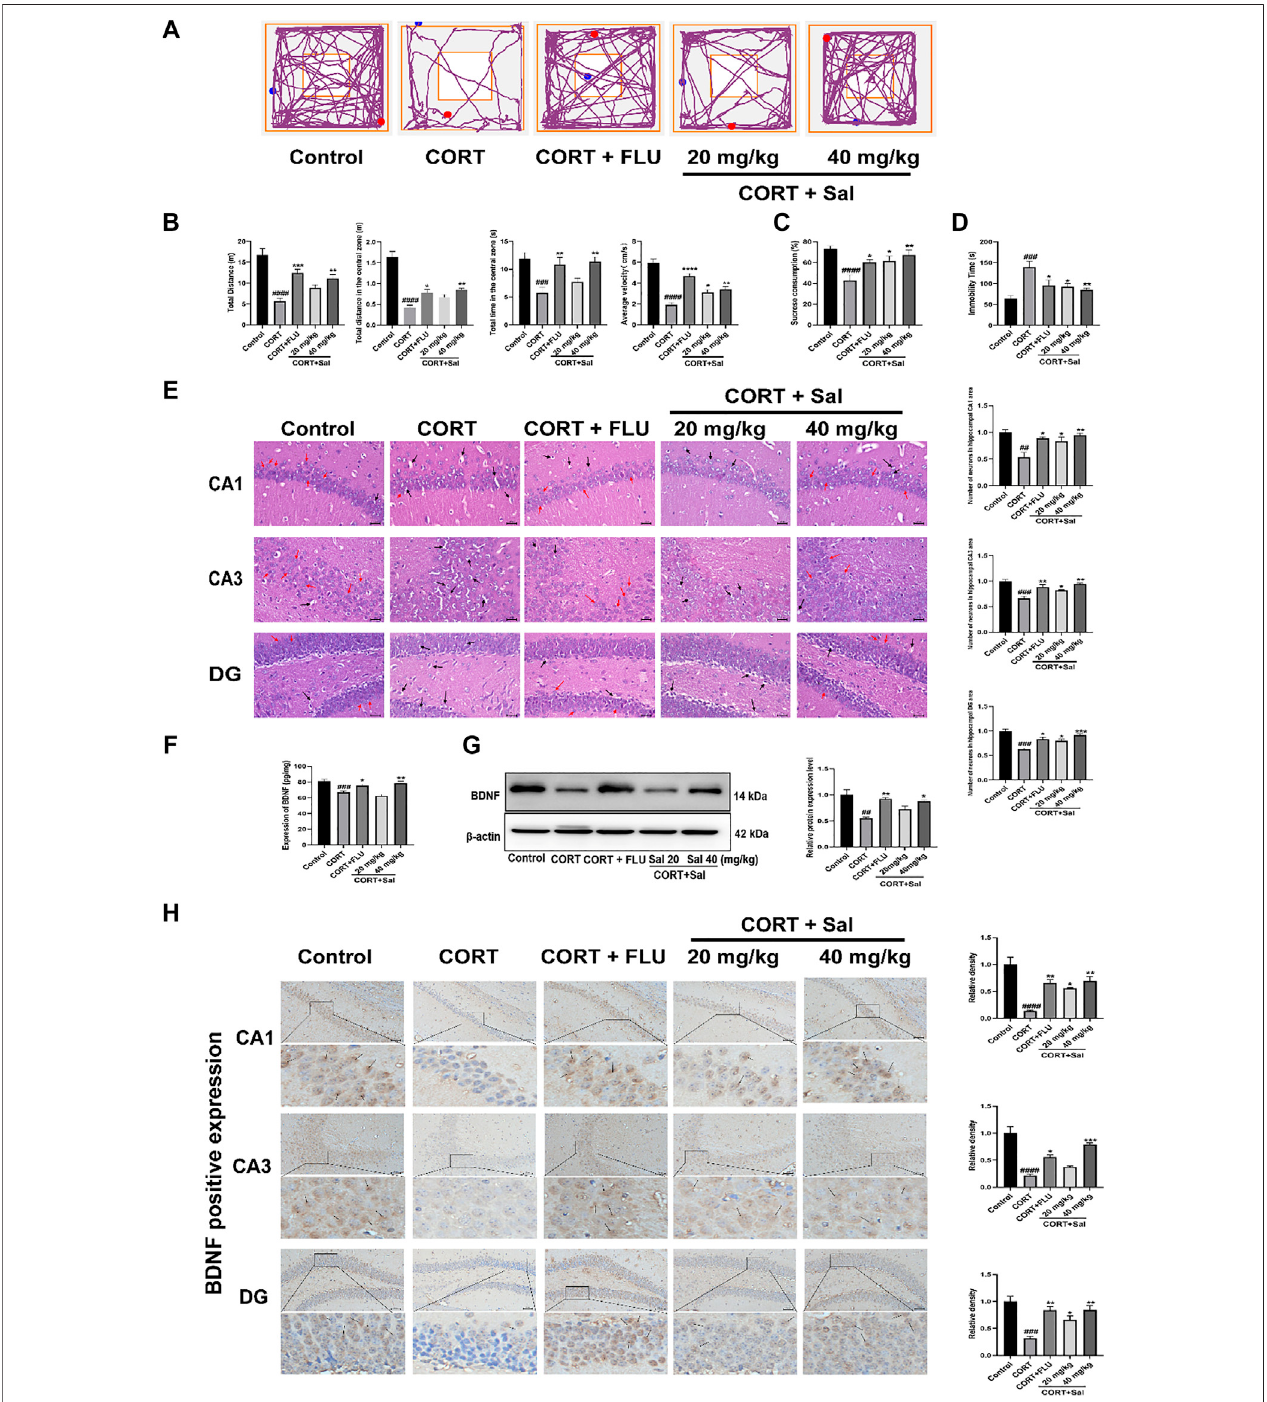
FIGURE 1 | Effects of Sal in CORT-induced depression in mice. (A) Representative tracks of different experimental groups in OFT. (B) Sal improved locomotor activity in the OFT ( n = 10). (C) Sal ameliorated the consumption of sucrose solution in the SPT ( n = 10). (D) Sal decreased the immobility time in the FST ( n = 5). (E) HE staining to evaluate the pathological changes in the hippocampus. Cells have pyknotic nuclei with vacuolated cytoplasm (black arrows) and normal neuronal cells (red arrows)(magni fi cation:×400,Scalebar=25 μ m, n =3). (F) ThelevelsofBDNFinthehippocampuswasexaminedusingELISAkits( n =5). (G) SalimprovedCORT- induced the decrease of BDNF in the hippocampus was determined by Western blot ( n = 3). (H) Immunochemical staining and the relative density of BDNF in hippocampus CA1, CA3, and DG. Brown staining represents the expression of BDNF (black arrows). Original magni fi cation: × 200, n = 3. #### p < 0.0001, ### p < 0.001, ## p < 0.01, # p < 0.05 versus the control group, **** p < 0.0001, *** p < 0.001, ** p < 0.01, * p < 0.05 versus the CORT group.